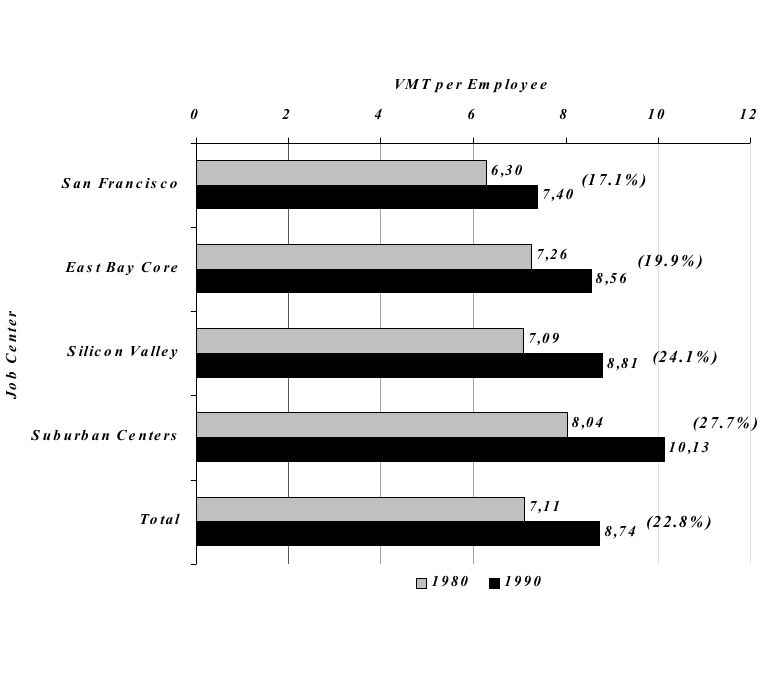
Figure 3. Comparison of Worker Vehicle Miles Travelled (VMT) per Capita Across Four Classes of Employment Centres in the San Francisco Bay Area, 1980 and